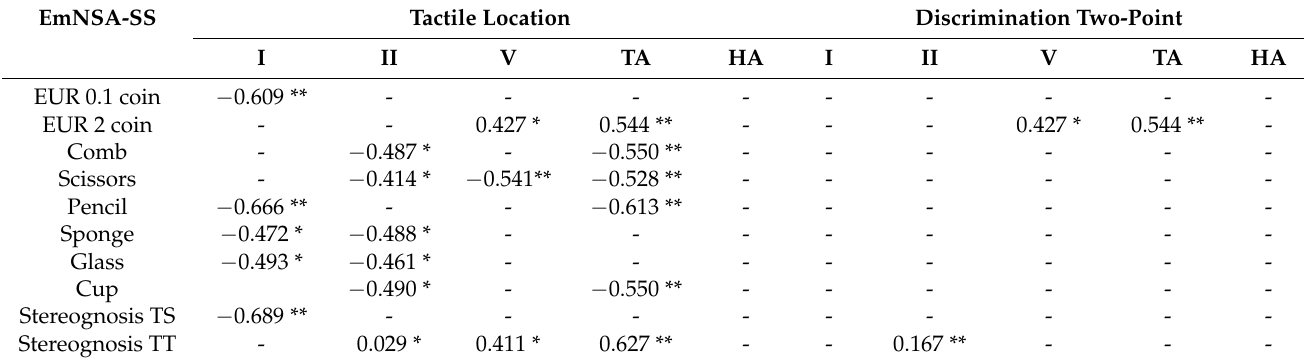
Table 4. Concurrent criterion validation, Spearman’s correlation coefficient between stereognosis subtest, two-point discrimination, and tactile localization ( n =